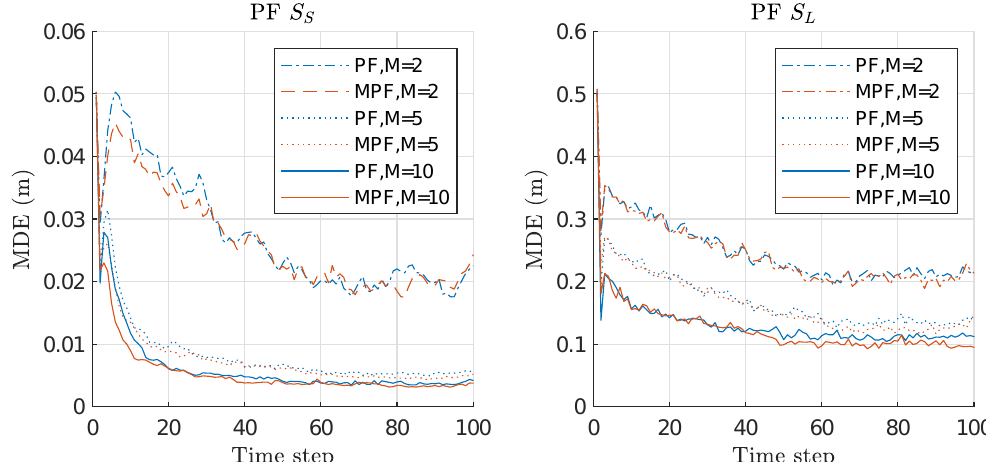
Figure 1. Mean distance error (MDE) performance comparison between particle filtering (PF) and minimax PF (MPF). Three hundred runs were performed with 1000 particles, where M , S S , and S L denote the number of sensors, the scenario of the small state noise variance, and the scenario of the large state noise variance, respectively.